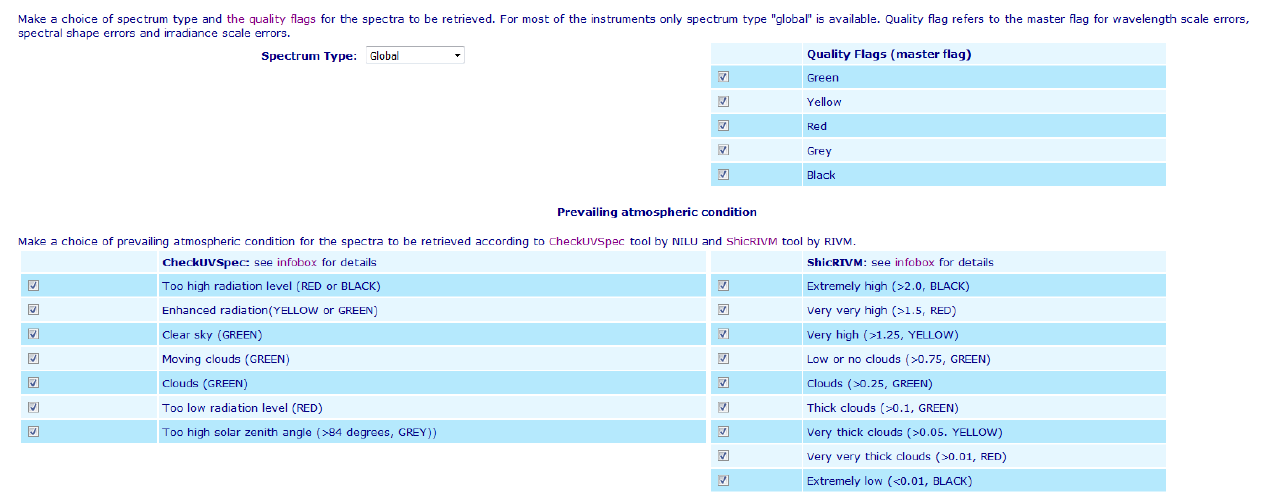
Figure 1. Screenshot on the www-based interface for making query into the EUVDB. The query may be restricted to a desired subset of flag colours.